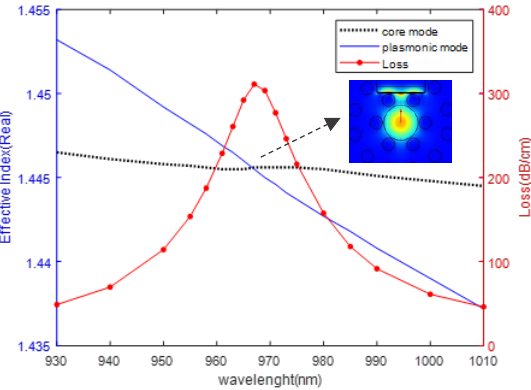
FIGURE 2. Distribution of the effective refractive index of the sensor and confinement loss diagram. (d=2 μ m, d c =2.8 μ m, h a =0.45 μ m, t Au =0.05 μ m, n a =1.45, n c =1.46)